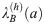
Flow diagram of the compartmental model for VZV transmission and reactivation.Boxes denotes epidemiological compartments (M = maternal antibody, S = susceptible to varicella infection, I = varicella infective, HZS1 = first time zoster susceptible, etc.), while arrows denote transfers between compartments; ω(a) denotes the rate of loss of maternal antibodies, λ(a) the varicella force of infection (FOI), γ the varicella recovery rate, λB(h)(a) (h = 1,2,3…) the force of exogenous boosting (FOB), and ρi(a) (i = 1,2,3…) the rates of HZ development in each HZ susceptibility stage.